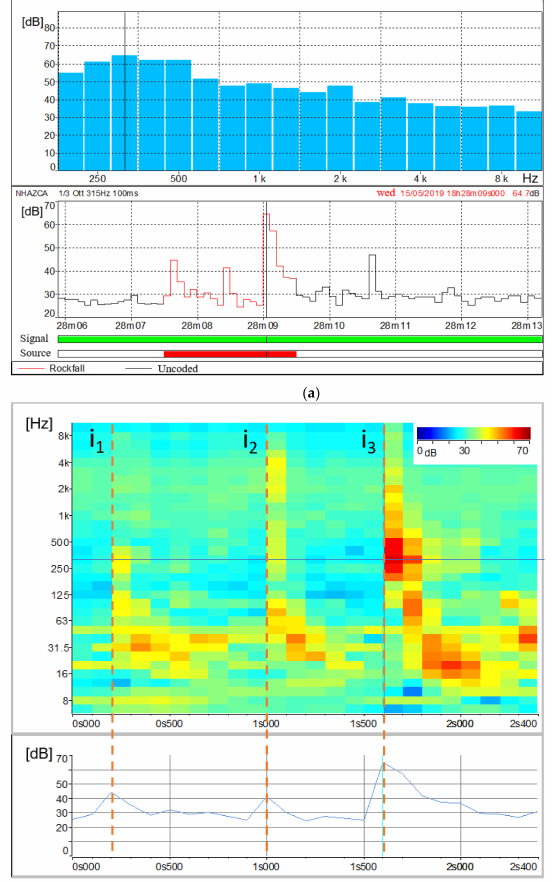
Figure 12. Overall representation of the acoustic signal emitted by the rockfall event on 15 May 2019 at 18:28 (UTC + 01:00) with its related impacts (i 1 , i 2 and i 3 ): ( a ) Spectral time history of the rockfall event with the classified soundtrack (lower plot) and frequencies histogram (upper plot); ( b ) Focus on the audio track classified as rockfall by means of the sonogram showing the amount of sound pressure levels expressed in dB as a function of time and signal frequency. The plot at the bottom shows the amount of sound pressure level over time at the frequency of 315 Hz. Temporal resolution is 0.1